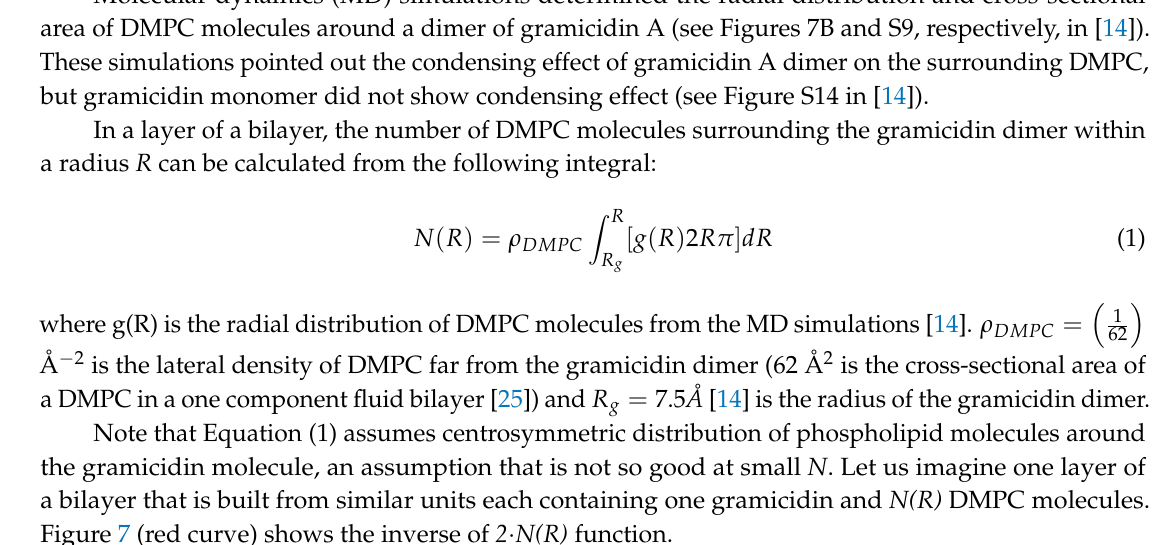
Figure 7. Condensing effect of gramicidin dimer. Red and blue curves are the radius, R and cross- sectional area, (cid:1827) (cid:3014) = (cid:1844) (cid:2870) (cid:2024) , respectively, of a rigid cluster as a function of the number of hydrocarbon chains, within a layer of the bilayer, condensed to a gramicidin dimer, M (=2 N). These curves were